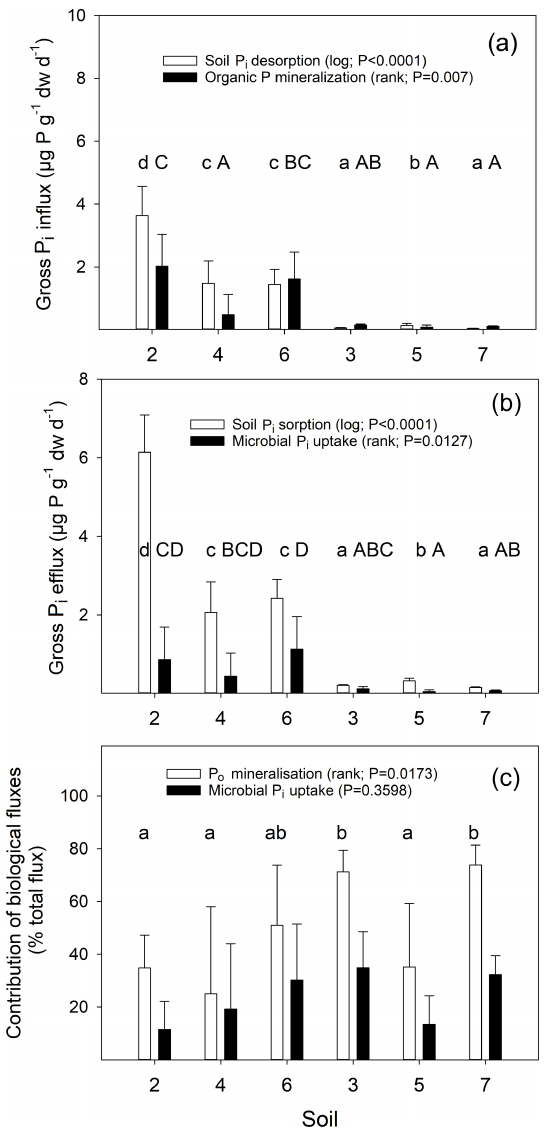
Figure 7. Gross influx rates into the available soil P i pool (a) and gross efflux rates from this pool (b) measured by 33 P isotope pool dilution for six soils over the time period from 4 to 24h and assessed in sterile and live soils. Abiotic and biotic process rates are indi- cated by open and closed bars, respectively. Temperate grassland soils (2, 4 and 6) and tropical forest soils (3, 5 and 7) were stud- ied. Presented are means ± 1SD of triplicate live and sterile soils per time point and soil type. A one-way ANOVA was performed on transformed data, as indicated in parentheses. Different lowercase letters indicate significant differences between soils for abiotic pro- cesses (open bars), uppercase letters indicate significant differences between soils for biological processes (black